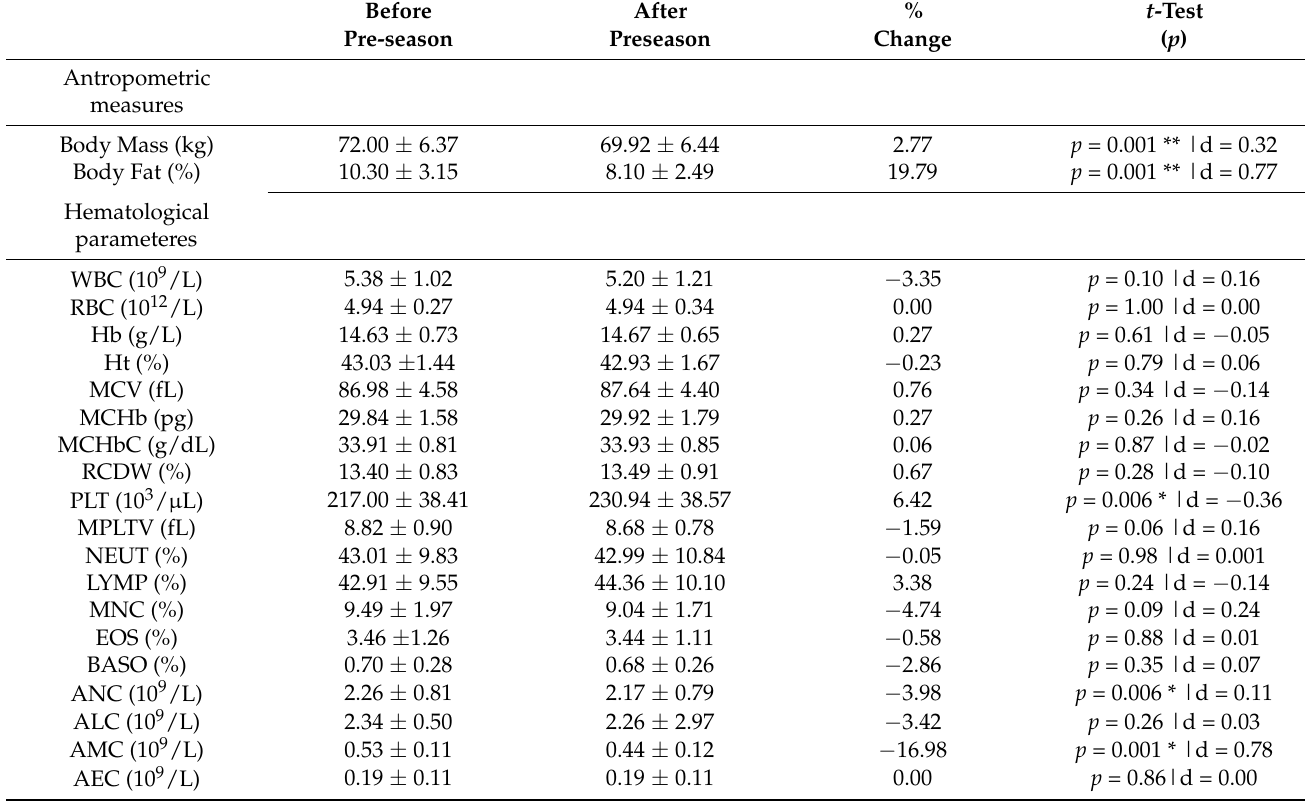
Table 1. Before and after pre-season data (mean ± SD) of anthropometric and hematological parameters (HP).